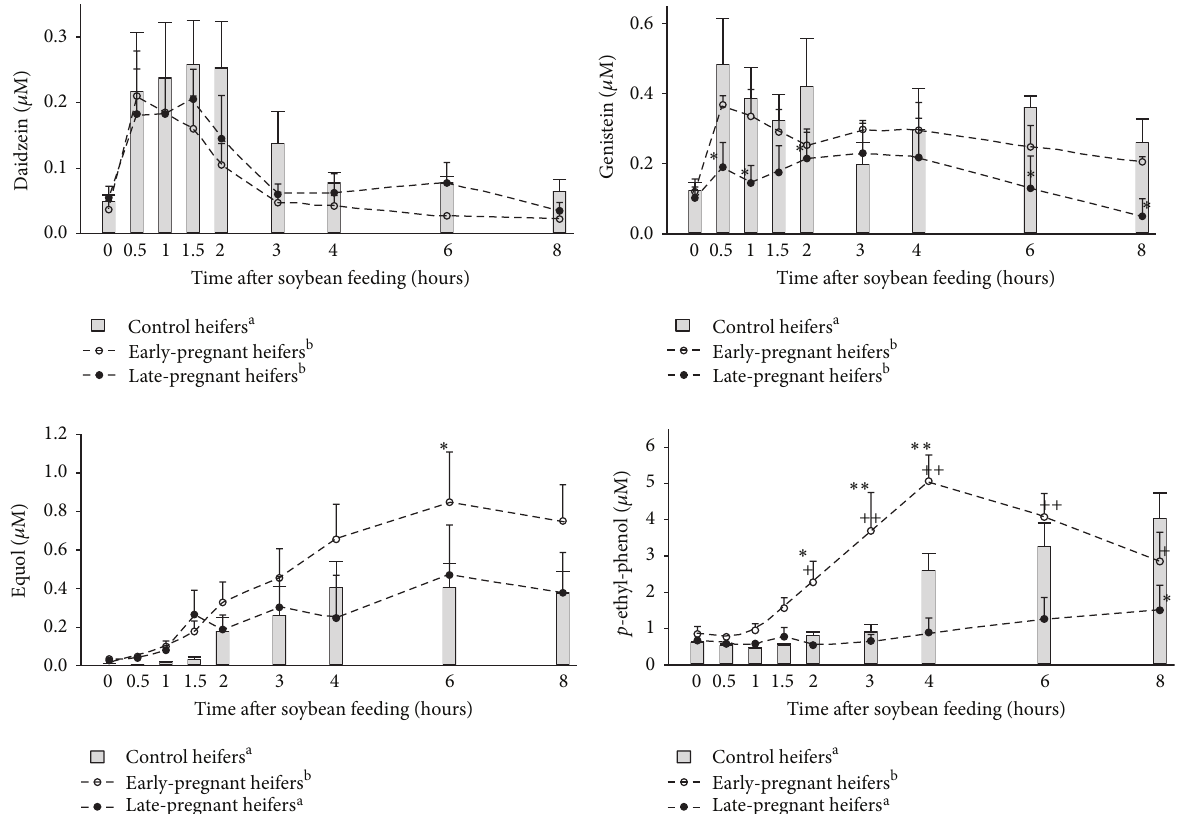
Figure 3: Time-dependent effect of soybean feeding on the concentrations of daidzein, genistein, equol, and para -ethyl-phenol in the blood plasma of the control, early-pregnant, and late-pregnant heifers (adapted from